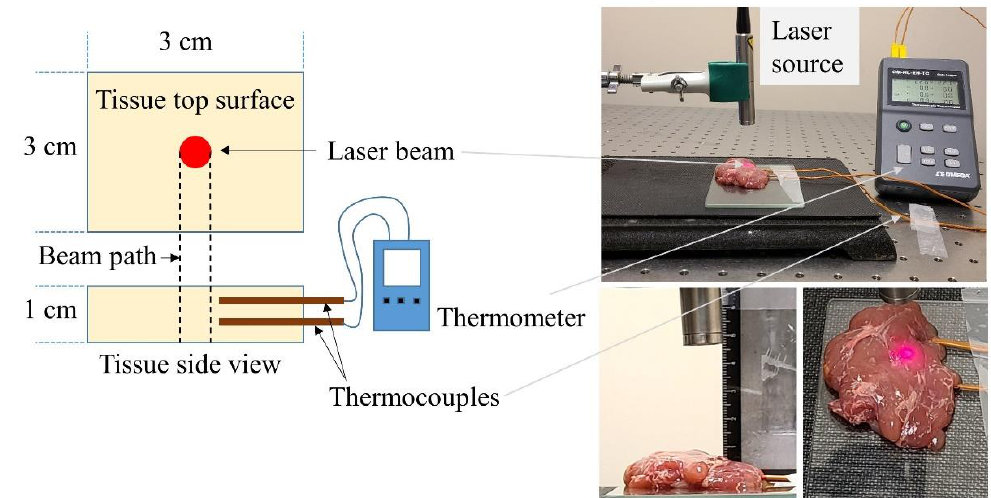
Figure 2. Experimental setup for the ex vivo porcine pancreas tissue photothermal heating by 808 and 1064 nm collimated laser beams. Note that the red guide beam is visible but is not the experimental light source.